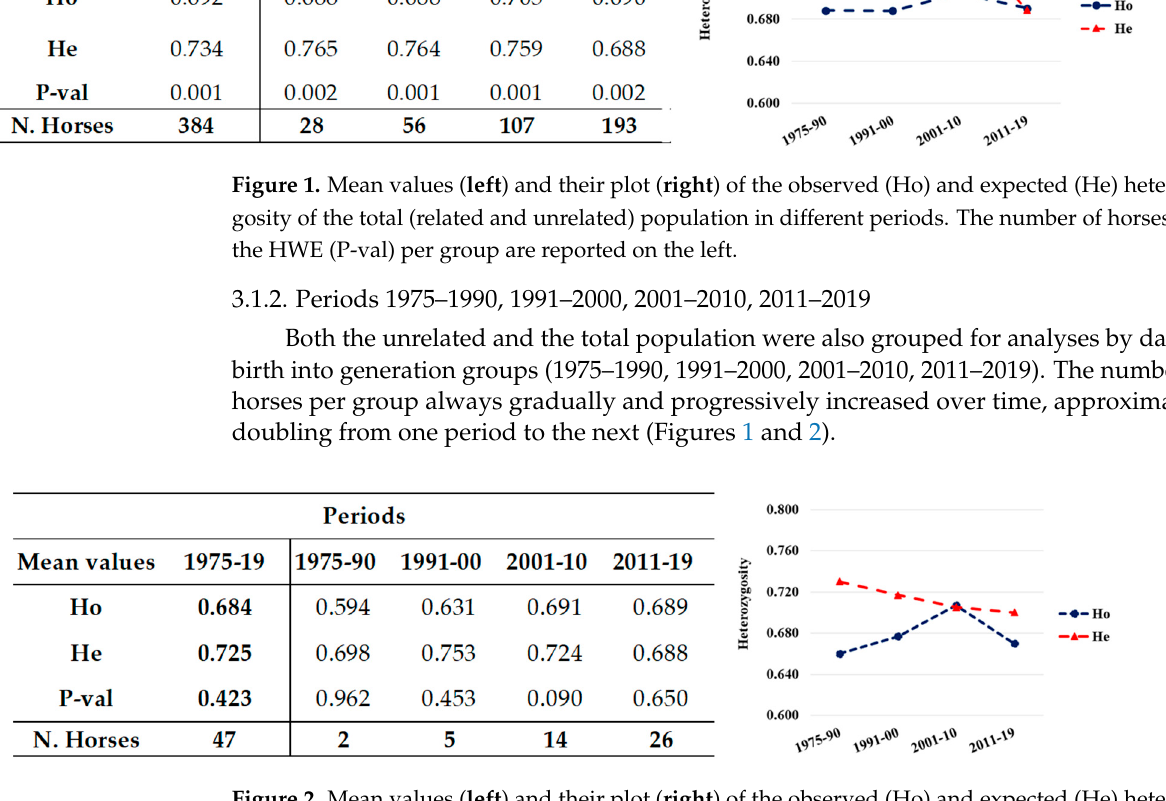
Figure 2. Mean values ( left ) and their plot ( right ) of the observed (Ho) and expected (He) heterozygosity of unrelated horses in different periods. The number of horses and the HWE (P-val) per group are reported on the left.